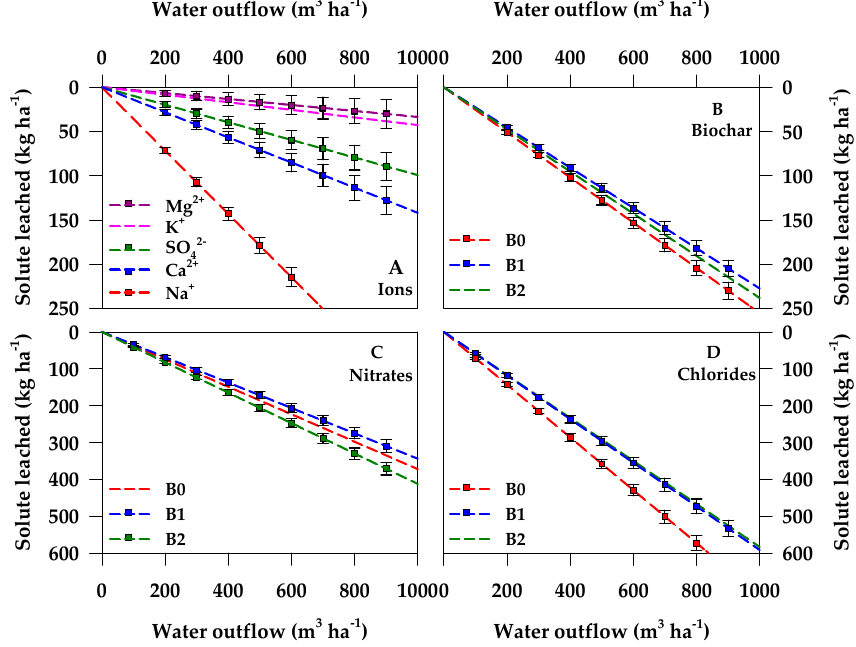
Figure 5. Set of linear regressions as result of the ANCOVA leaching model. ( A ) average effect of ions; ( B ) average effect of the biochar treatments (B0, B1, and B2); ( C ) interaction of nitrate with the biochar treatments; ( D ) interaction of chloride with the biochar treatments. The slope of the regression lines detects the average ion concentration in the drained water. To avoid overlapping, some symbols may be not